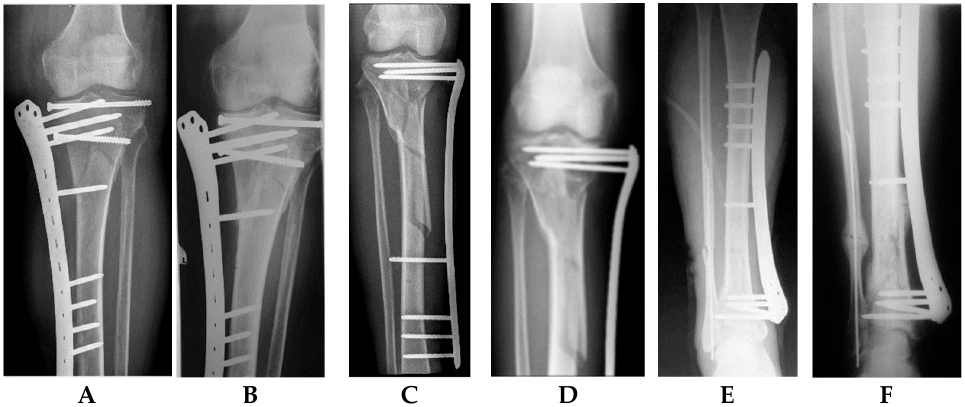
Figure 6. Post-operative ( A , C , E ) and final follow-up ( B , D , F ) radiographs of patients with an AO/OTA 41-C2.2 proximal tibial fracture with simple intra-articular involvement of both tibial condyles without intra-articular comminution and impaction (radiographs A , B ), an AO/OTA 41-A3.1 multi-fragmentary proximal tibial extra-articular fracture (radiographs C , D ), and an AO/OTA 43-A2.3 distal tibial multi-fragmentary meta-diaphyseal fracture (radiographs E , F ), all accompanied by significant soft tissue injuries and treated via single-stage externalized locked plating with LISS-DF.